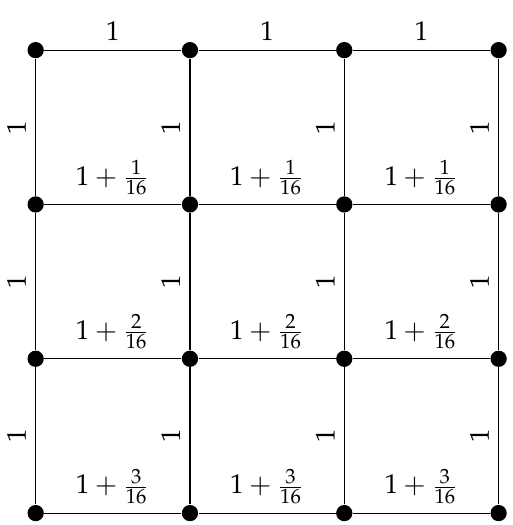
Figure 2. Lightheaded grid for n = 16, (cid:101) = 1/16.